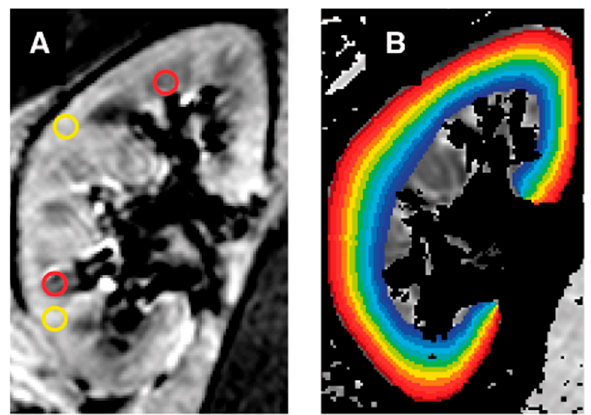
Figure 1. Demonstration of blood oxygenation level-dependent magnetic resonance imaging (BOLD MRI) kidney visualization. ( A ) Region of interest (ROI) technique with circles demonstrating ROIs, and ( B ) Twelve-layer concentric objects (TLCO) technique. (Figure reprinted with permission from Oxford Academic, from Prujim et al., 2018) .